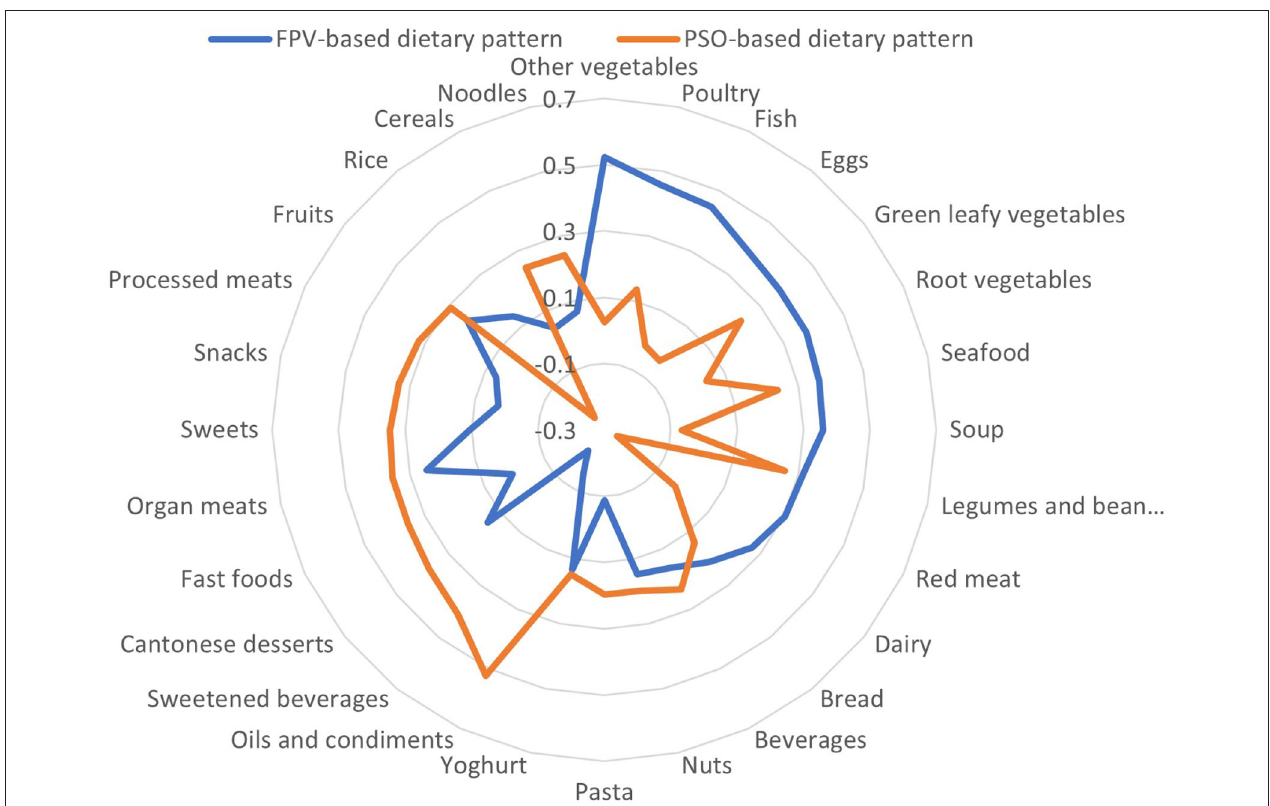
FIGURE 1 | Radar plot of the factor loadings of the 28 food groups on the two dietary patterns.